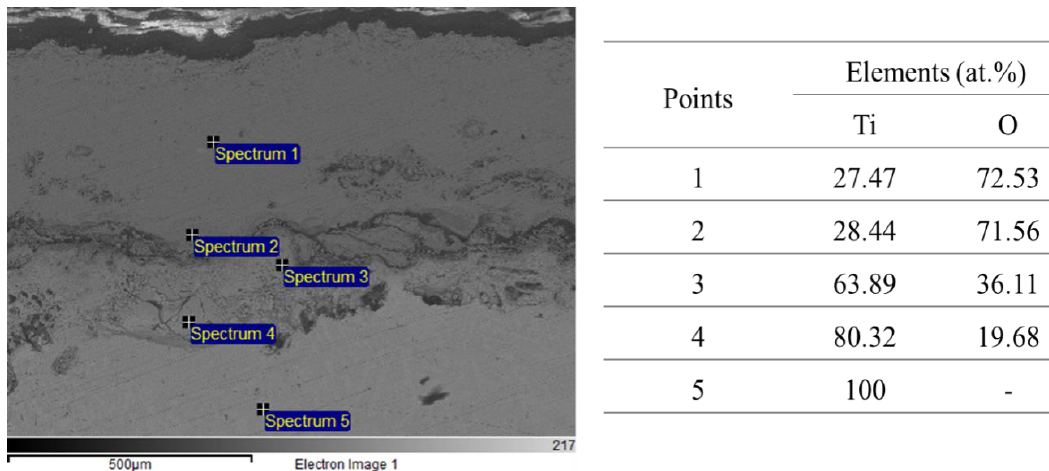
Figure 5. SEM image of the oxidized Ti at 900 C for 100 h.